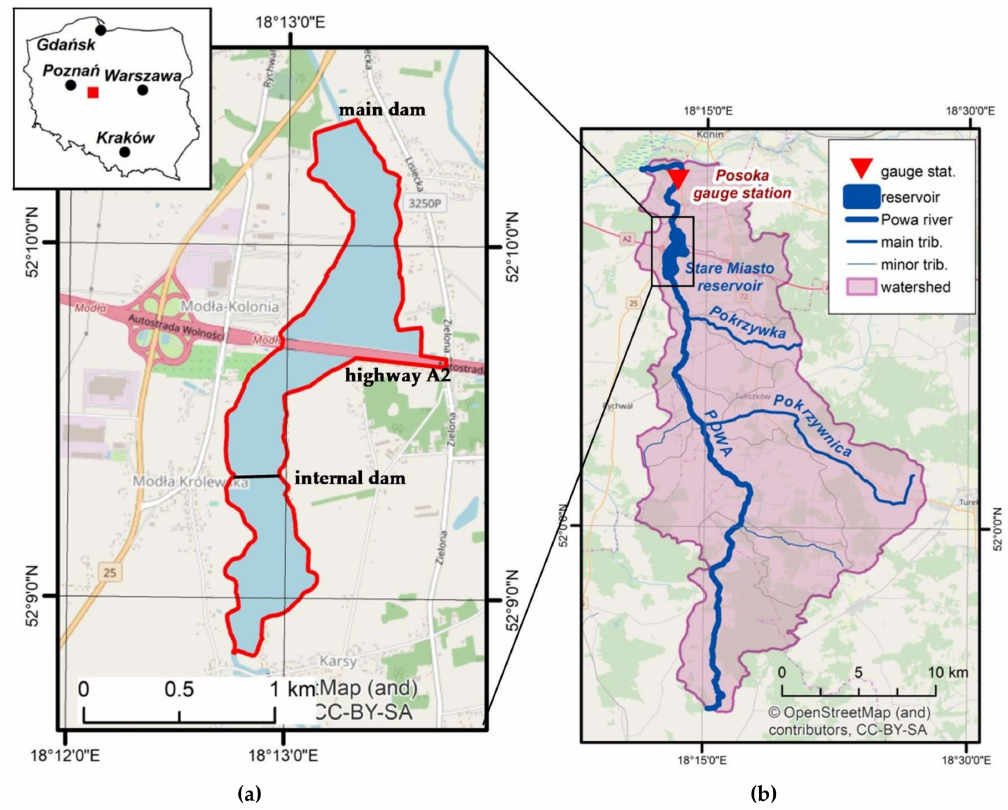
Figure 1. Chosen case study—Stare Miasto reservoir on the Powa river: ( a ) The reservoir and its main elements—internal dam, highway bridge, and main dam; ( b ) the watershed with main elements—river, reservoirs, and gauge station.